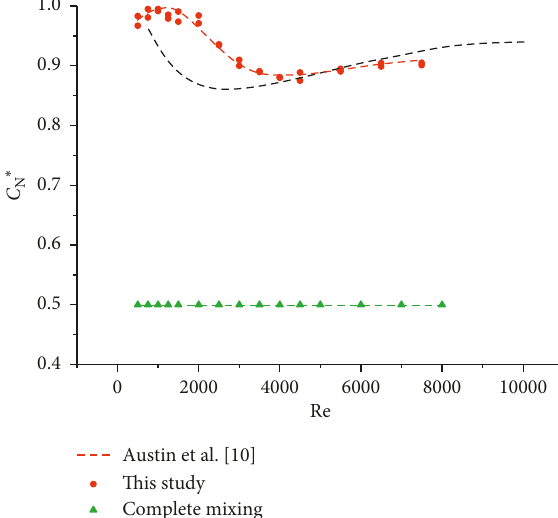
Figure 10: Comparison of experimental results between Austin et al. [10] and this